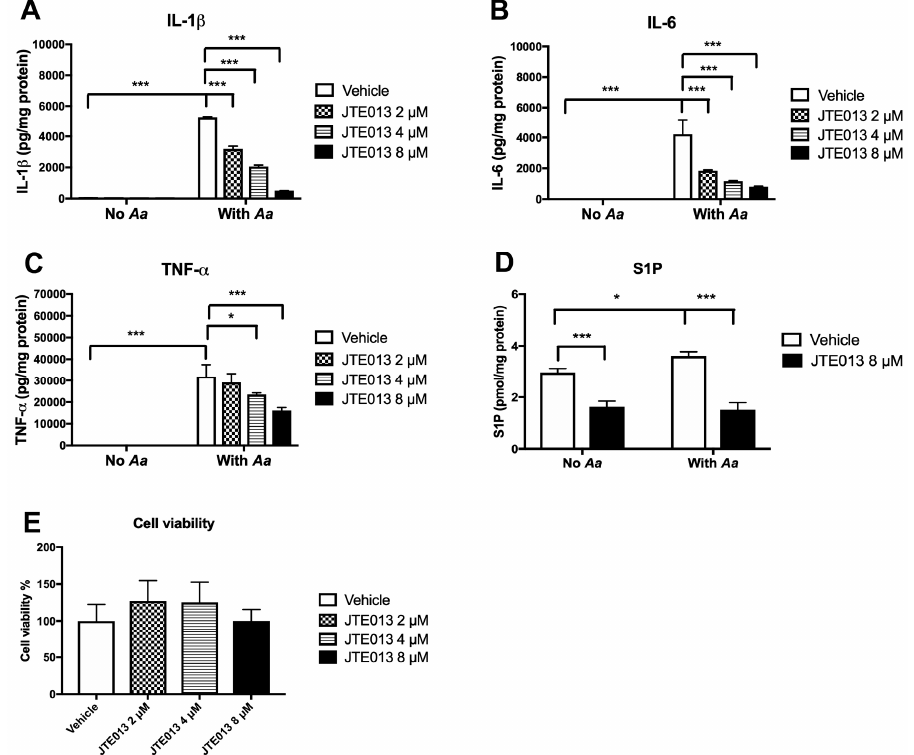
Figure 1. Inhibition of S1PR2 by its specific antagonist (JTE013) significantly decreased IL-1 β , IL-6, TNF-a, and S1P levels induced by Aa in BMMs. Murine BMMs were treated either with vehicle or JTE013 for 30 min. Then cells were either uninfected or infected with Aa for 6 h. ( A ) IL-1 β , ( B ) IL-6, and ( C ) TNF- α levels were quantified by ELISA. ( D ) S1P levels in cell protein lysates were quantified by mass spectrometry. Cytokine and S1P levels were normalized by protein levels in cell lysates. ( E ) Cell viability in BMMs treated with vehicle or JTE013 for 24 h. (* p < 0.05 *** p <